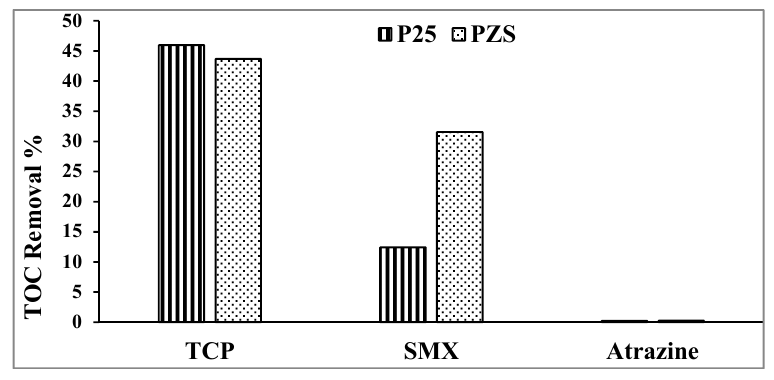
Figure 3. Percentage TOC removal after 1 h of irradiation.